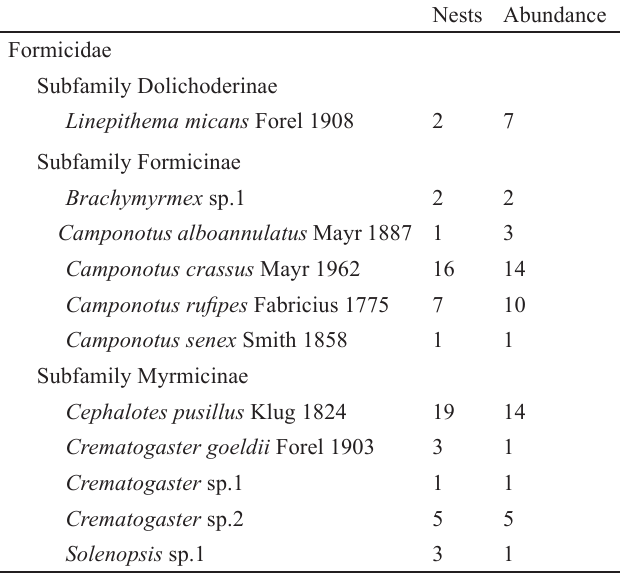
Table 1 . Ant species nesting in cavities found in burned and un- burned areas in a Brazilian Savanna area. Columns show nest quan- tity assessed with trap-nests and active search and local abundance assessed using pitfall traps.